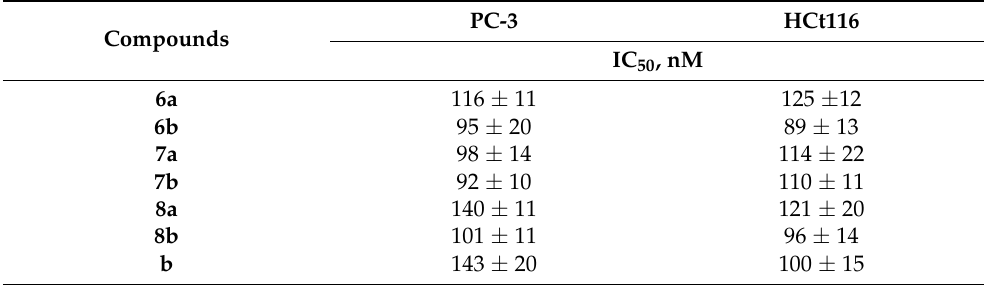
Table 1. The photoinduced activity of compounds in the system in vitro.